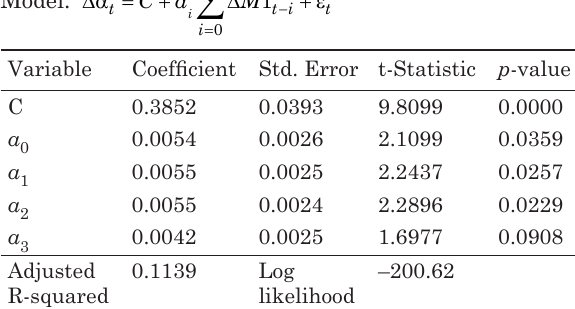
) and money supply (M1) t